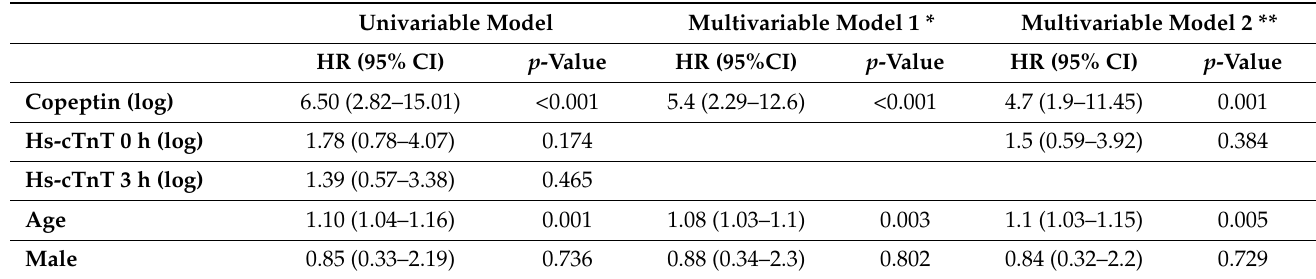
Table 4. Cox regression models for prediction of all-cause death at 365 days.